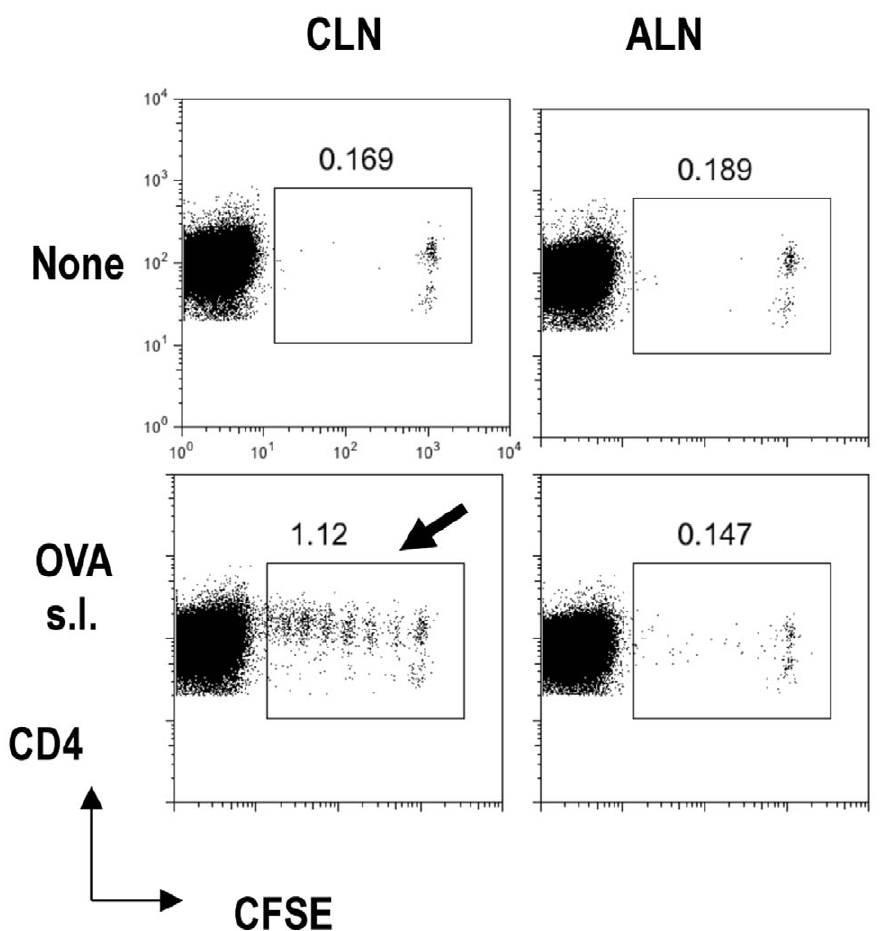
Figure 3. Cervical lymph nodes are draining lymph nodes from the oral cavity. CFSE-labeled OTII CD4 + T cells were adoptively transferred into B6 mice on day 2 1. On day 0, 500 m g of OVA was administered sublingually (s.l.). CLN or ALN was analyzed for CFSE dilution at day 3. One of two similar experiments is shown for the FACS plots. Plots were gated on CD4 + T cells.